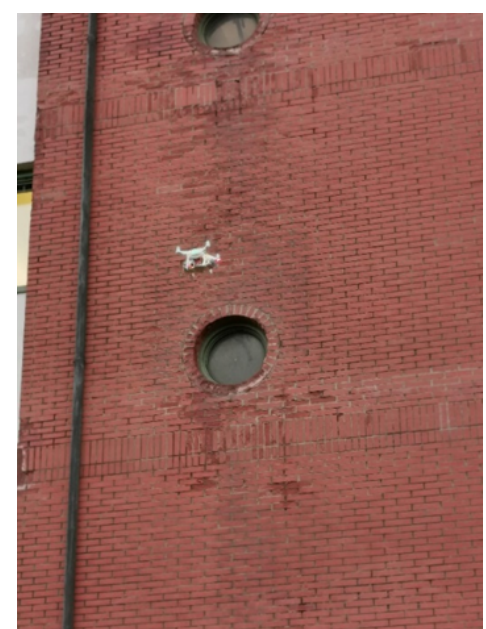
Figure 1. External sensors attached to the drone.